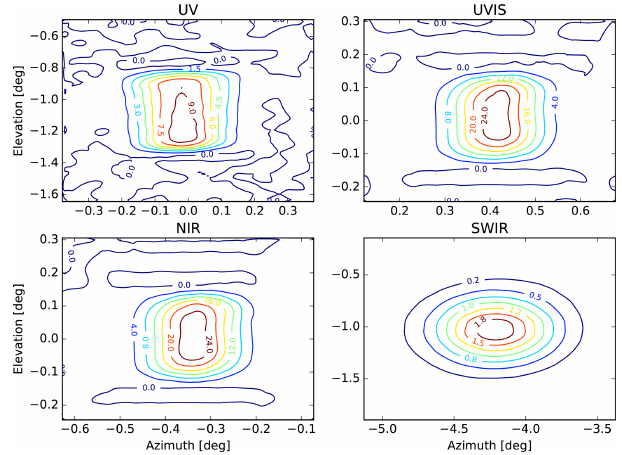
Figure 30. PRF contour plot for all detectors for a pixel in the mid- dle of the detector, showing a number of isolines versus the IRF azimuth–elevation angle window, which holds relevant